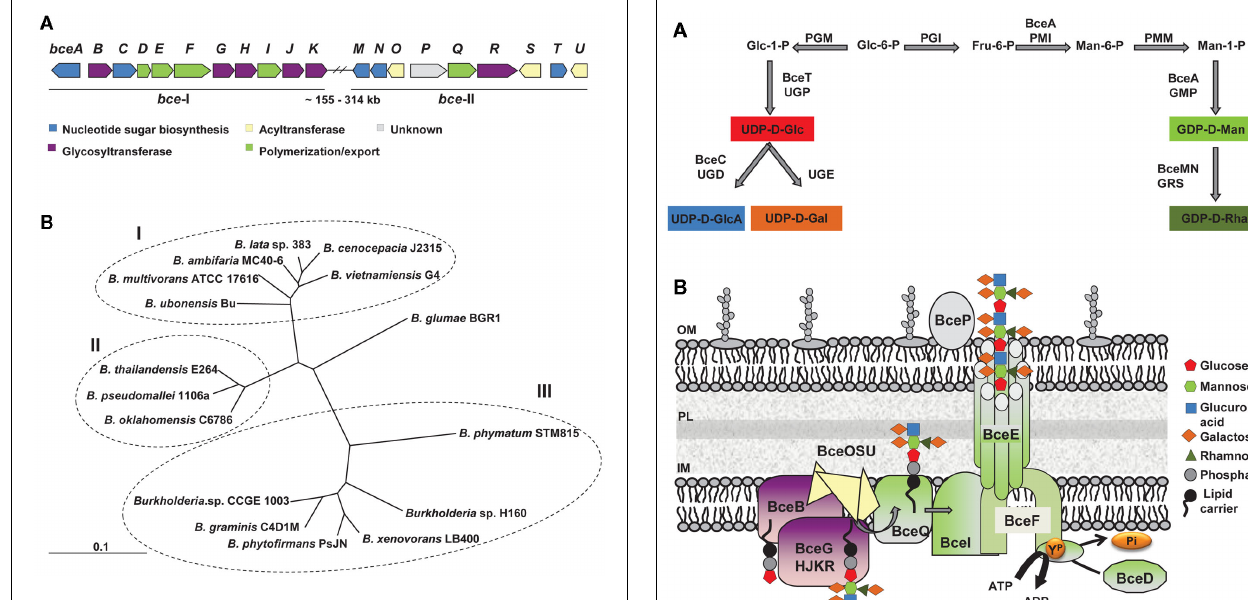
FIGURE 1 | Genes and proteins involved in cepacian biosynthesis. (A) Genetic organization of bce-I and bce-II clusters of genes encoding proteins involved in cepacian biosynthesis.With exception of B. xenovorans , B. phymatum , B. phytofirmans , B. graminis , Burkholderia sp. H160 and sp. CCGE 1003, in most of Burkholderia species, the two clusters are located approximately 155–314kb apart in the genome. (B) Neighbor-joining phylogenetic tree of the deduced amino acid sequences of Bce predicted proteins from 16 strains of Burkholderia distributed by 14 species.The several Bce protein sequences of each species were concatenated and were aligned by CLUSTALX 2.0 using 1000 bootstrap replicates and sorted byTreeView 1.6.6.The clusters obtained allow the distinction of Bc c strains (group I) from non- Bc c strains having the bce genes clustered separately (group II) or together (group III) in their genomes. Scale: number of substitutions per site.